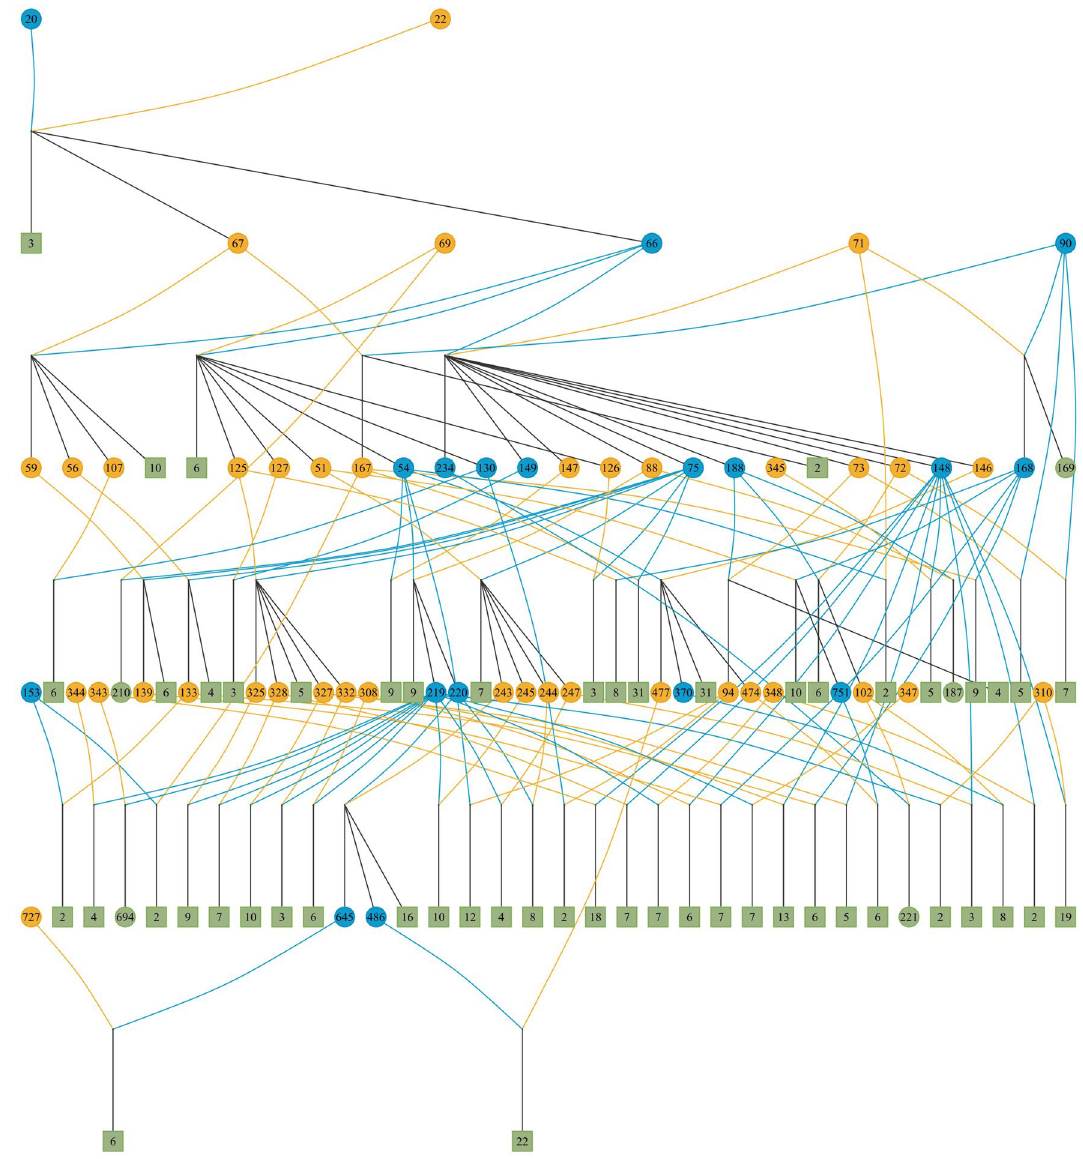
Figure 1. Gochu Asturcelta pig pedigree available. Numbers within circles are the identifications of the reproductive males (boars; in blue circles) and females (sows; in orange circles). Numbers within green squares inform on the offspring size of a parental couple excluded the offspring kept for reproduction. Green circles indicate that a given parental couple had one offspring